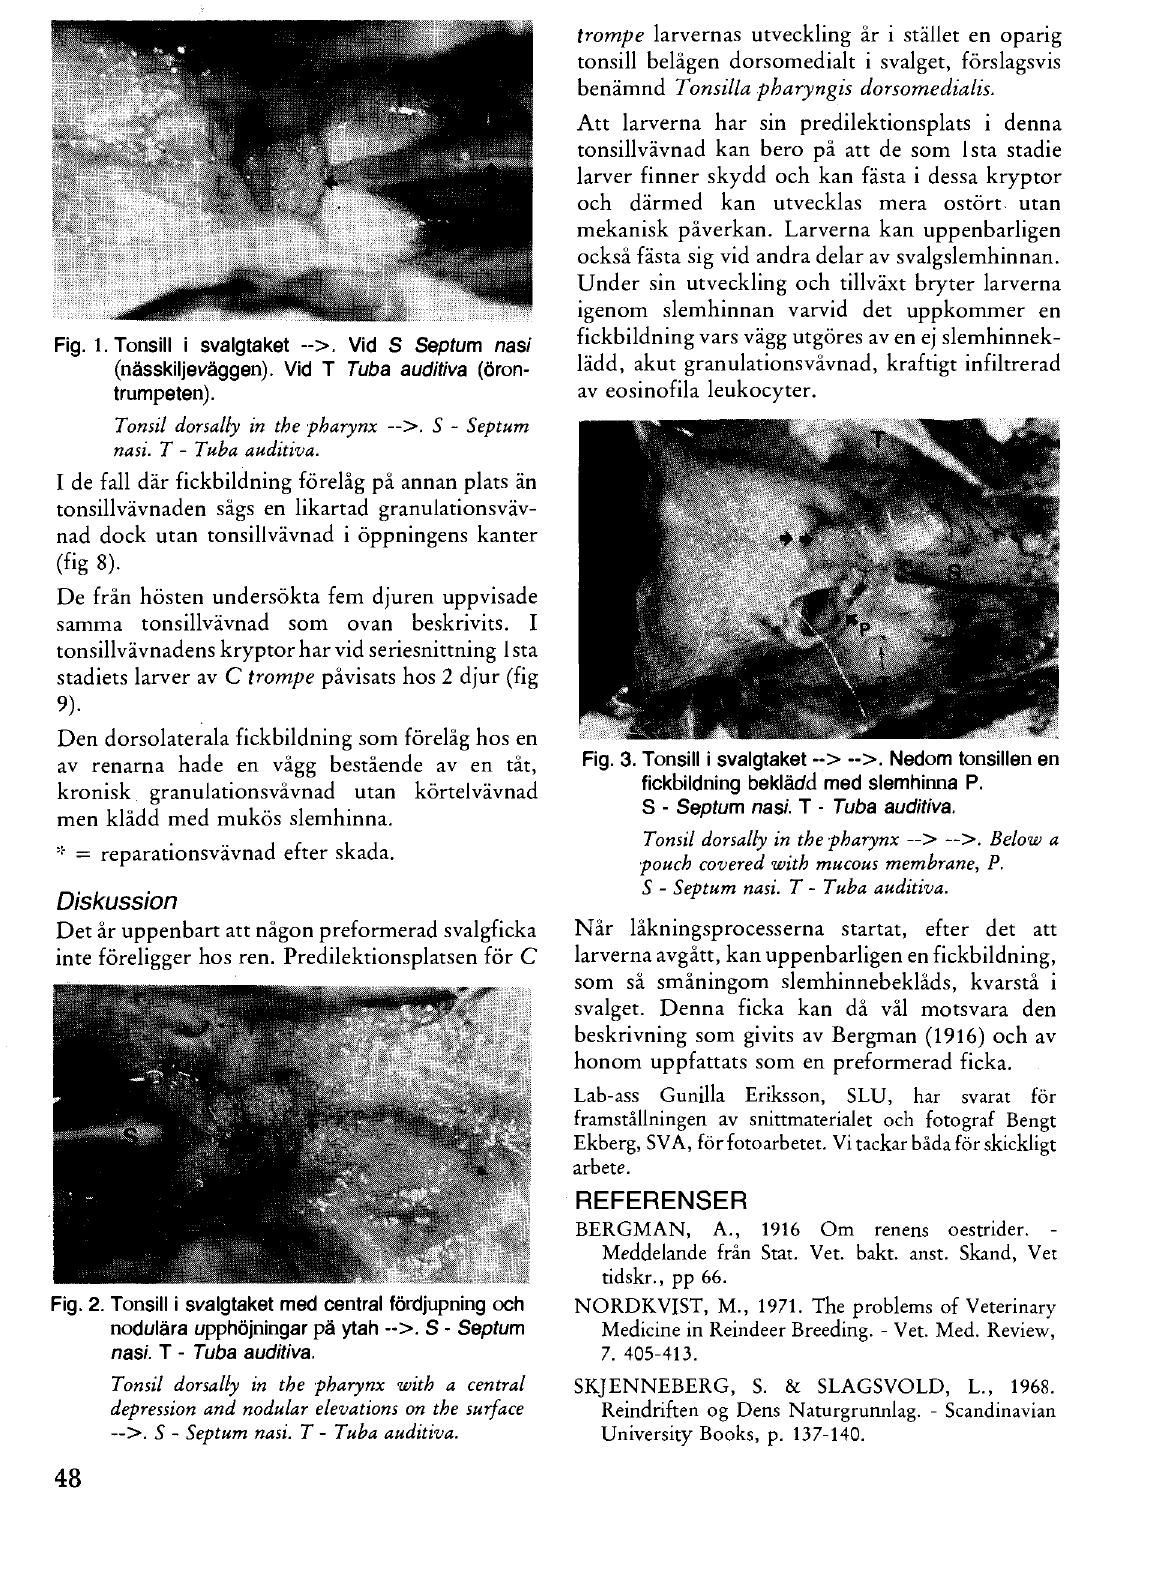
Fig. 2. Tonsill i svalgtaket med central fördjupning och nodulära upphöjningar pä ytah -->. S - Septum nasi. T - Tuba auditiva.